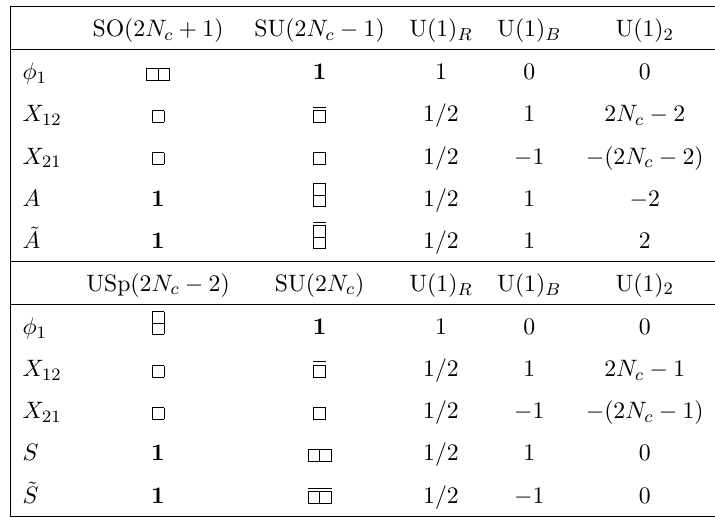
Table 7 . Matter content and charges of N = 1 S-dual quivers with n g = 1